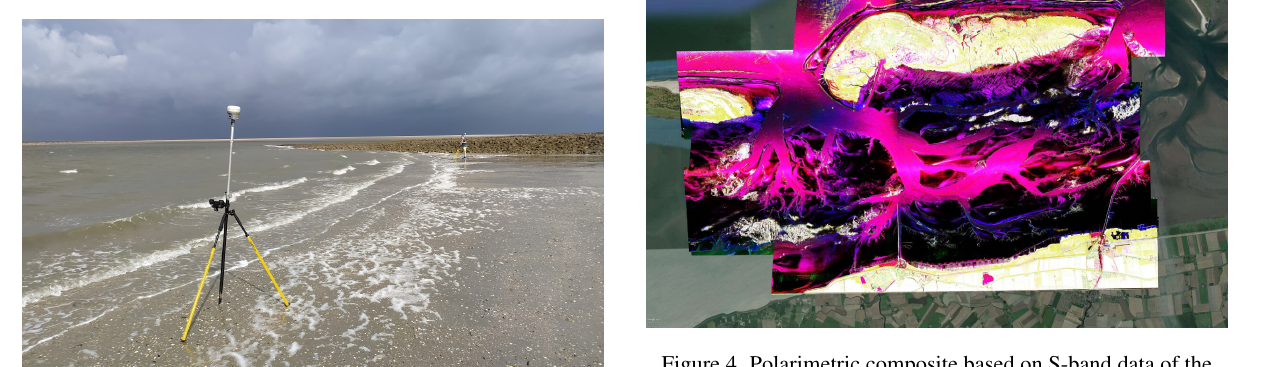
Figure 4. Polarimetric composite based on S-band data of the study